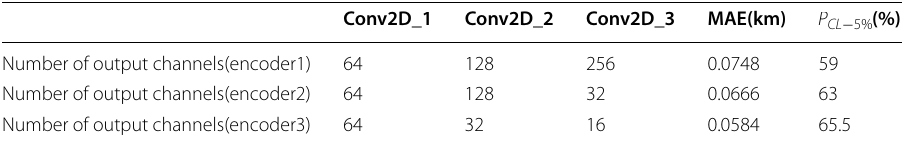
Table 4 Parameters of the encoder in CAE